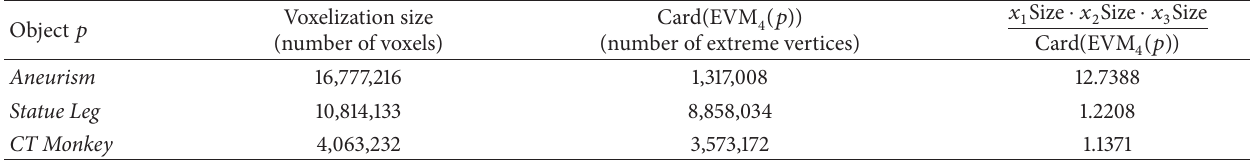
Table 2: The ratio number of voxels/number of extreme vertices for datasets shown in Table 1.